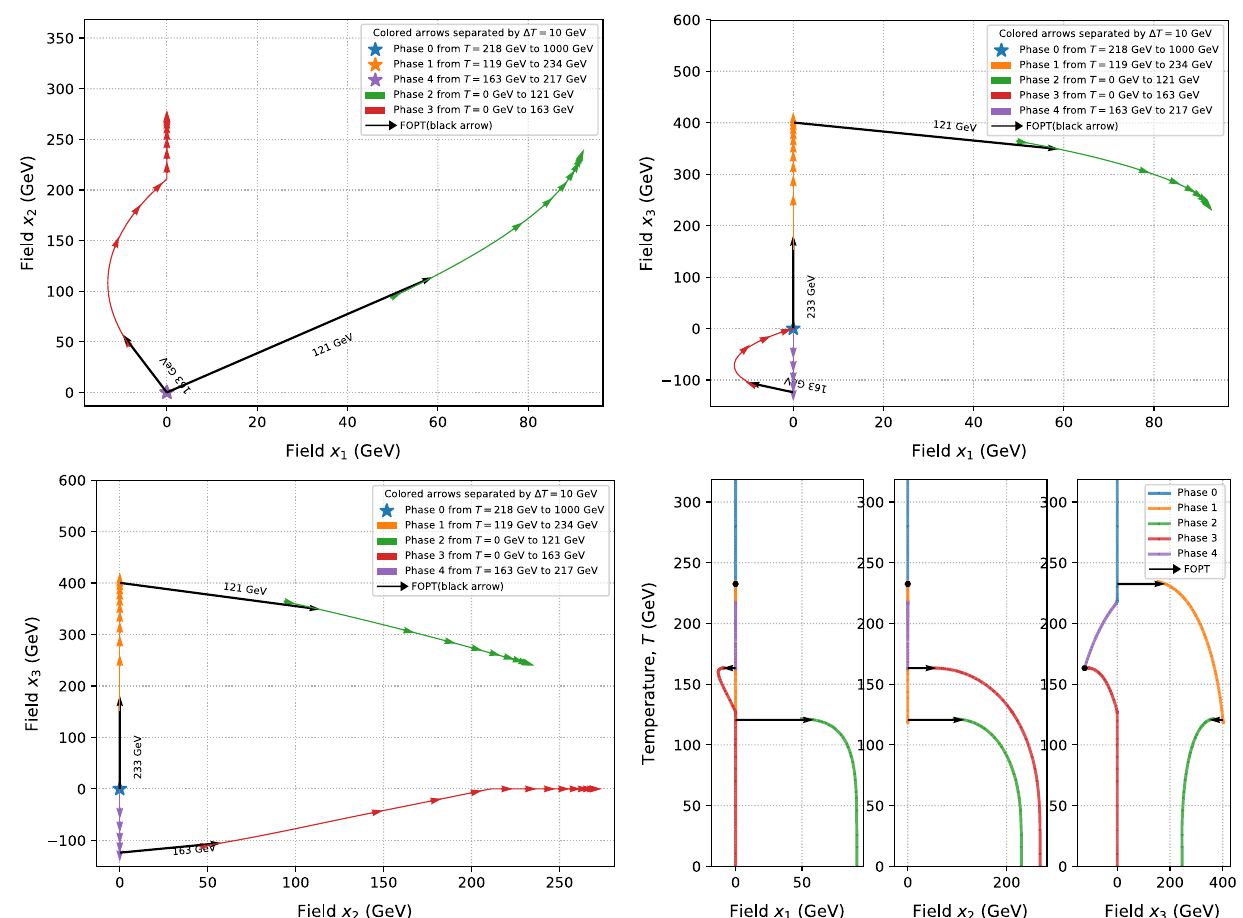
Fig. 5 Phase structure of the NMSSM. The meanings of the upper panels and the lower left panel is same to the left panel of Fig. 3. The meanings of the right panel is similar to the right panel of Fig. 2. The